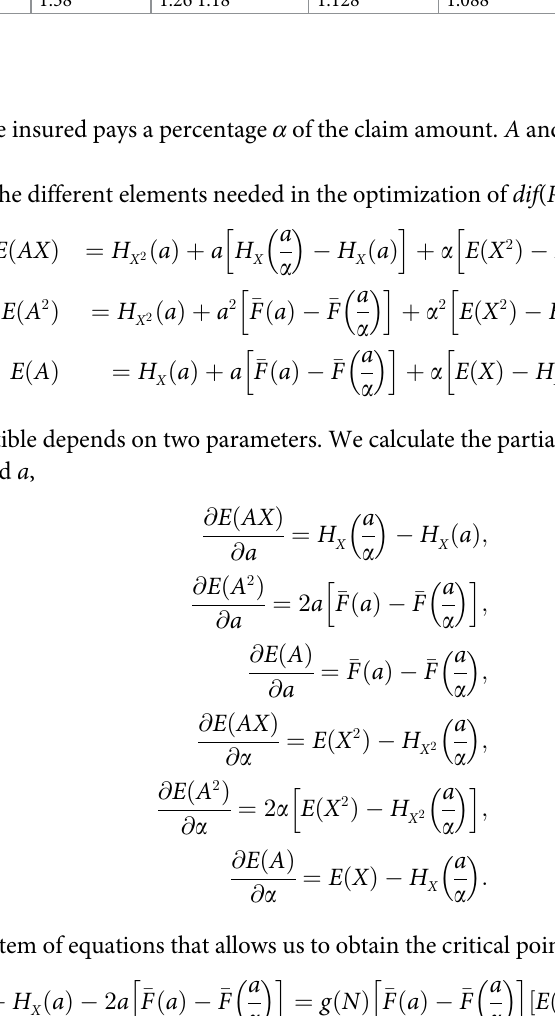
Table 6. Optimal B if the proportional deductible with limit is applied in the Poisson-Lognormal case for a > 1 α 0.55